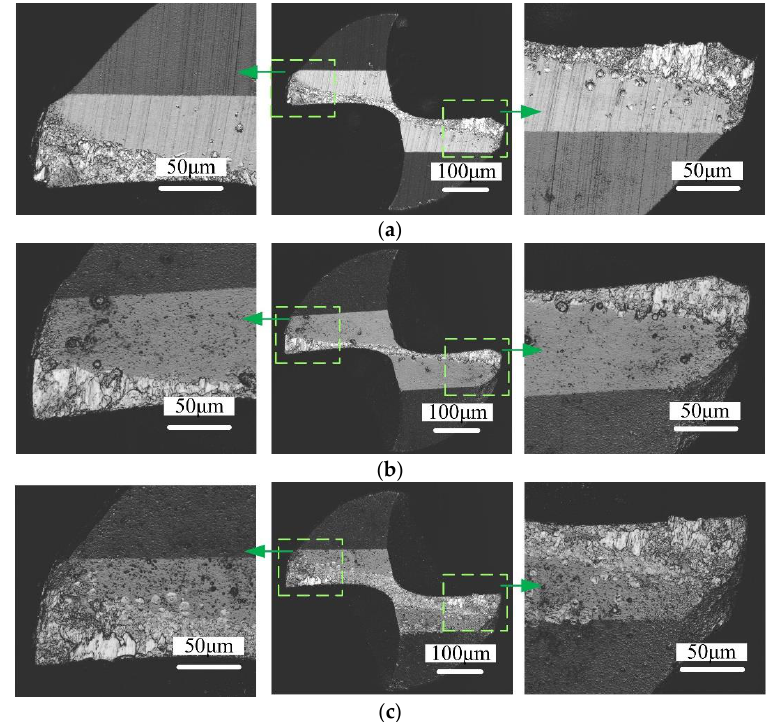
Table 3. Experiment cutting